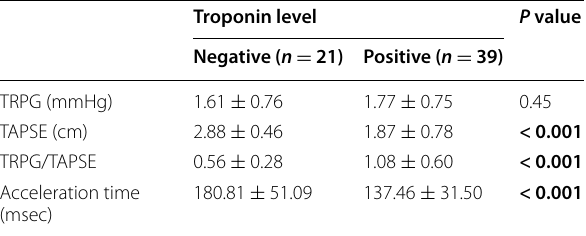
Data expressed as mean (SD). P value was significant if < 0.05